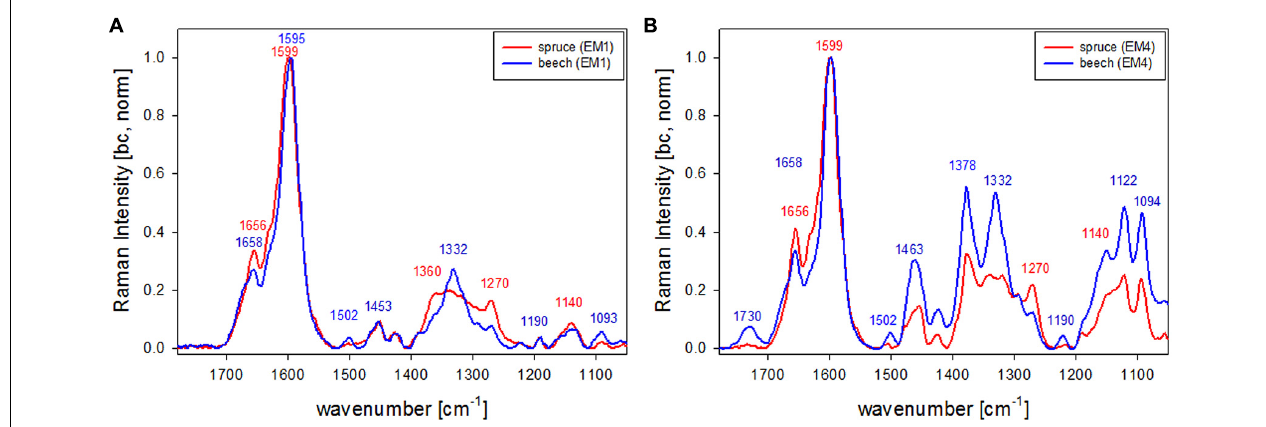
FIGURE 6 | Comparison of Raman spectra of spruce and beech after baseline correction and normalization on the aromatic stretching vibration at 1599 cm − 1 based the analysis shown in Figures 2 and 3 representing CC and CML (EM1,A) and the secondary cell wall (EM4, B; red line: spruce, blue line: